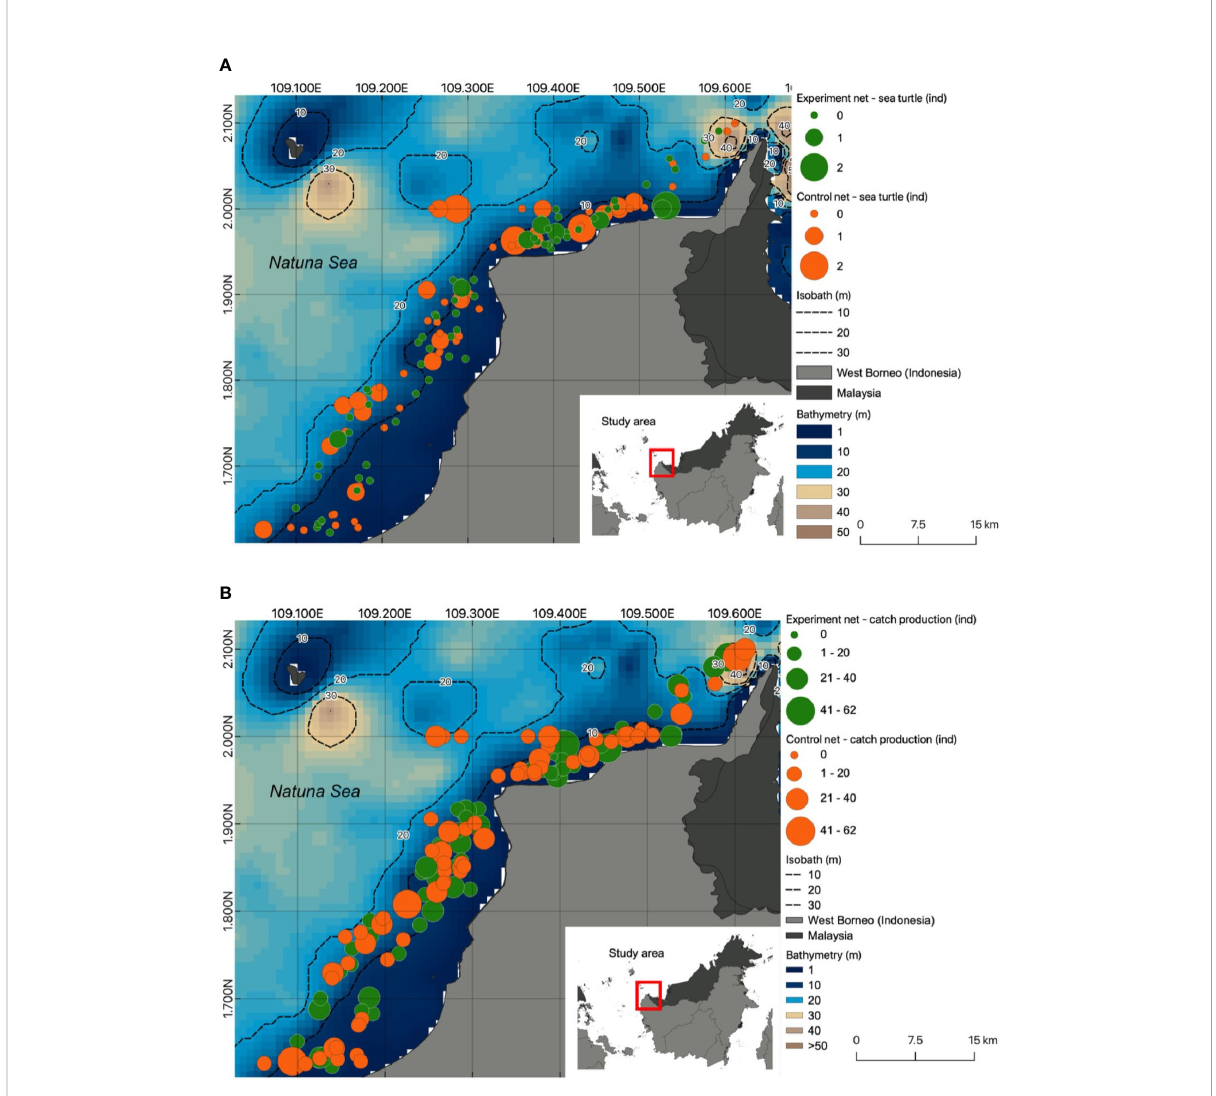
FIGURE 1 Location of gillnet sets in Paloh waters, West Kalimantan, Indonesia. Control nets are shaded in orange and experimental, illuminated nets are shaded green. The level of catch is shown by the size of the circles. (A) Location and quantity of sea turtle bycatch for each net set. (B) Location and quantity of marketable catch for each